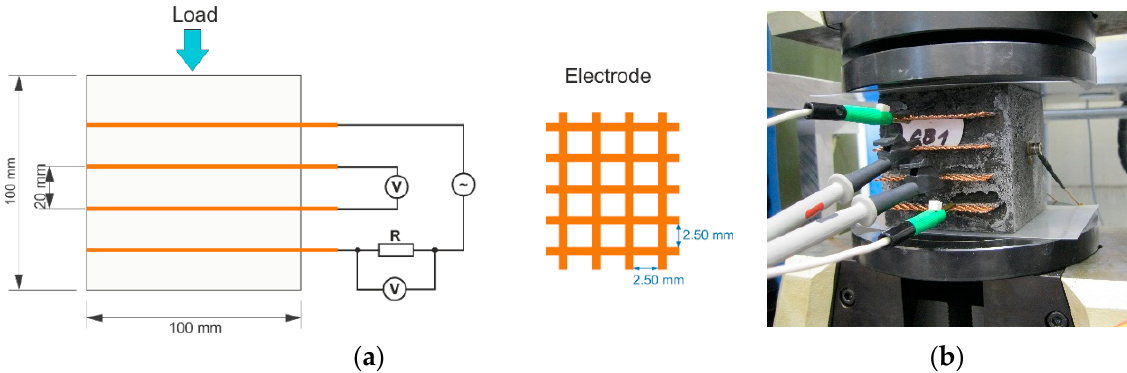
Figure 2. Experimental setup for the measurement of self-sensing properties under compression. ( a ) schematic plot; ( b ) picture of the setup during testing.